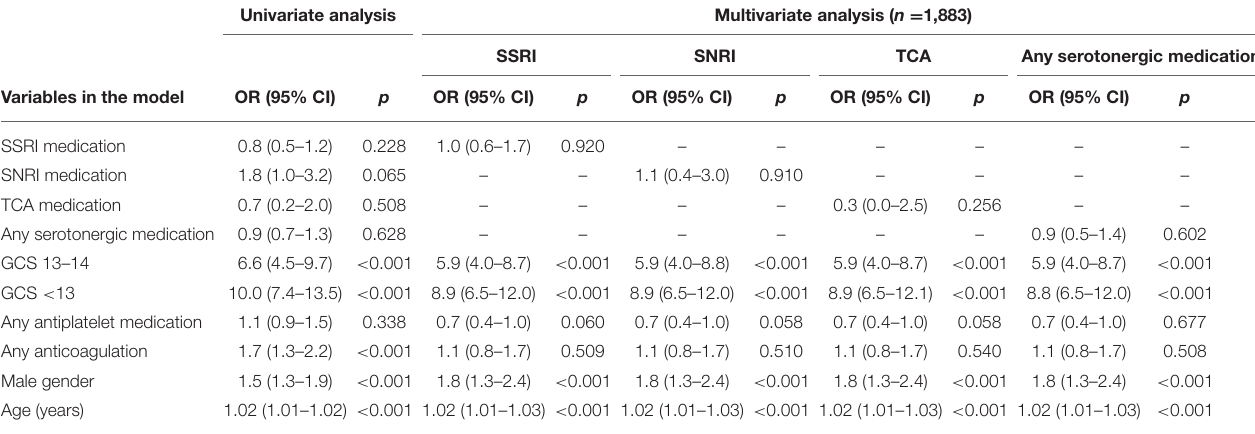
TABLE 4 | Univariate and multivariate logistic regression analyses on CT-positive acute traumatic intracranial hemorrhage (no CSDH). Univariate